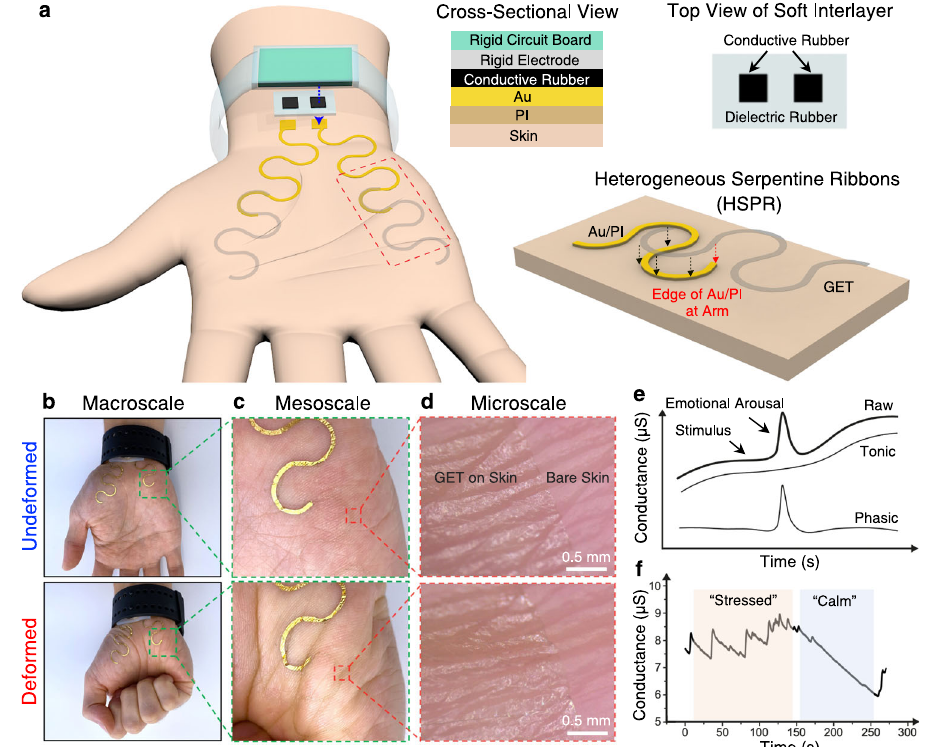
Fig. 1 | A wireless palm electrodermal activity (EDA) sensor based on sub- micron-thin graphene e-tattoo (GET) connecting to a rigid E4 EDA wristband through heterogeneous serpentine ribbons (HSPR) and a soft interlayer. a An overall device schematic where the detailed structures of the HSPR and the soft interlayer are illustrated in blown-up views. The HSPR is composed of GET ser- pentine ribbon partially overlapping with Au/PI serpentine ribbon via just van der Waals forces. The cross-sectionalview along the blue dashed arrow illustrates how